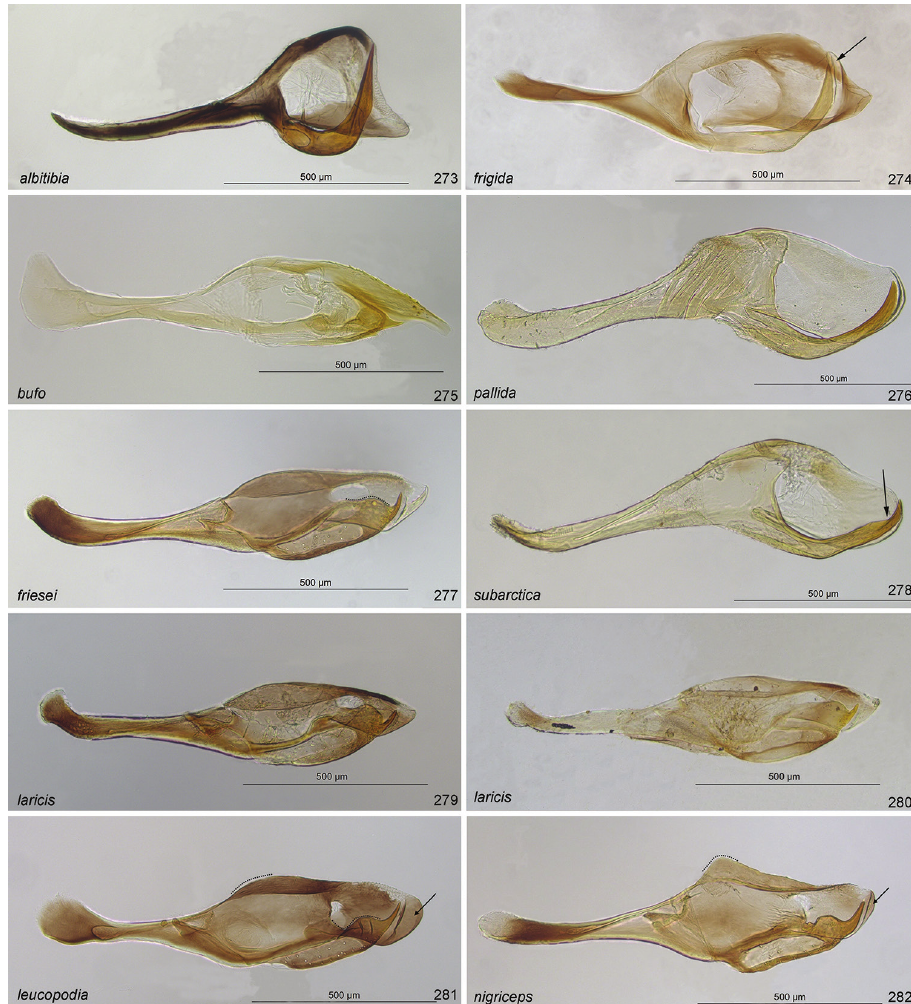
Figures 273–282. Penis valves of Pristiphora . 273 albitibia DEI-GISHym20956 274 frigida NHRS-HEVA000003861 (arrow indicates a membranous fold near the tip of valvispina) 275 bufo PR.410VV 276 pallida DEI-GISHym31587 277 friesei DEI-GISHym80003 278 subarctica NHRS- HEVA000003752, paratype (arrow indicates a depression at the apical part of valvispina) 279 laricis DEI-GISHym20917 280 laricis DEI-GISHym31553 281 leucopodia 1f_PR.739VV (arrow indicates broad pseudocepal thickening) 282 nigriceps BC ZSM HYM 10976 (arrow indicates narrow pseudoce- pal